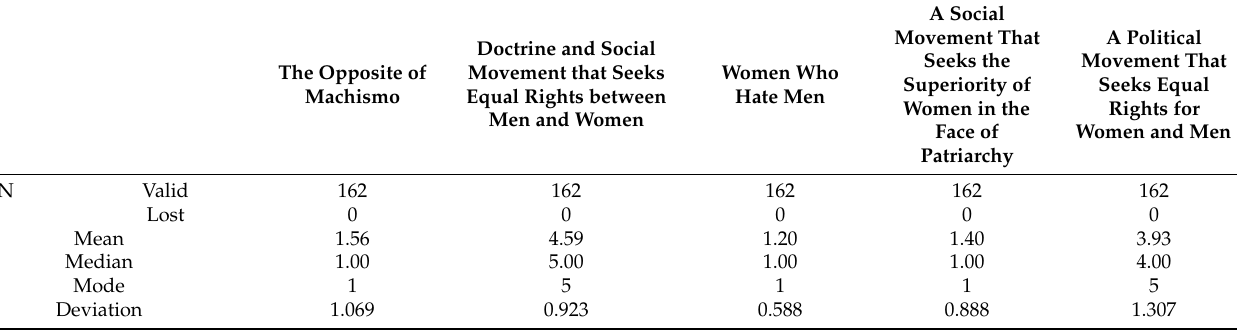
Table 5. Descriptive statistics of central tendency for question 3.